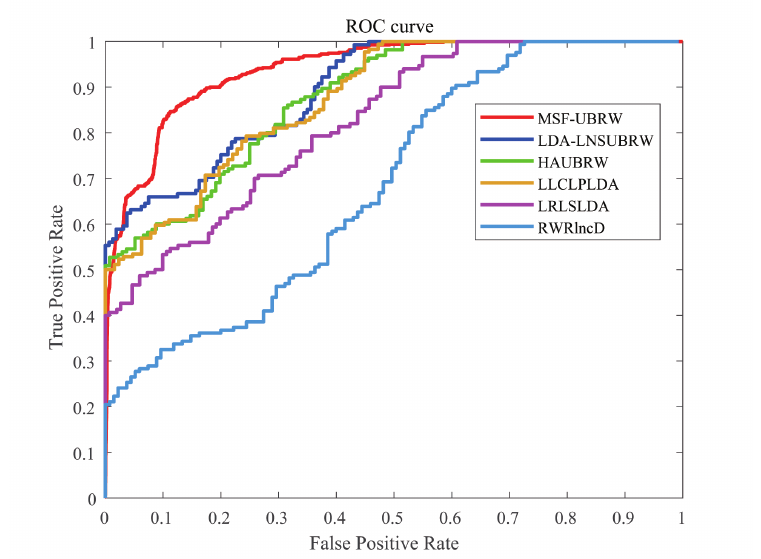
Figure 4. The ROC curves of the six methods (MSF-UBRW, LDA-LNSUBRW, HAUBRW, LLCLPLDA, LRLSLDA and RWRlncD) based on the LOOCV